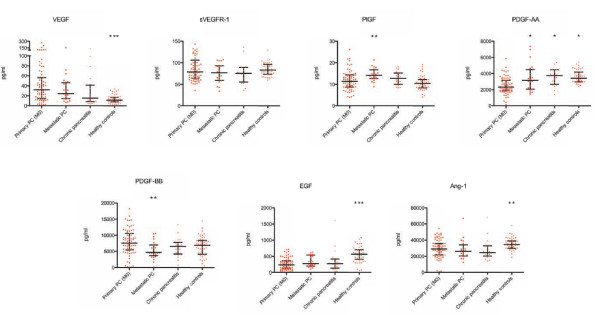
Expression of seven circulating angiogenic cytokines in patients with primary pancreatic cancer (M0), metastatic pancreatic cancer, chronic pancreatitis and healthy control subjects. Data are presented as median and interquartile range (black bars). * p < 0.05; ** p < 0.01; *** p < 0.001 (Mann-Whitney U test). Comparisons refer to the group of patients with primary pancreatic cancer.